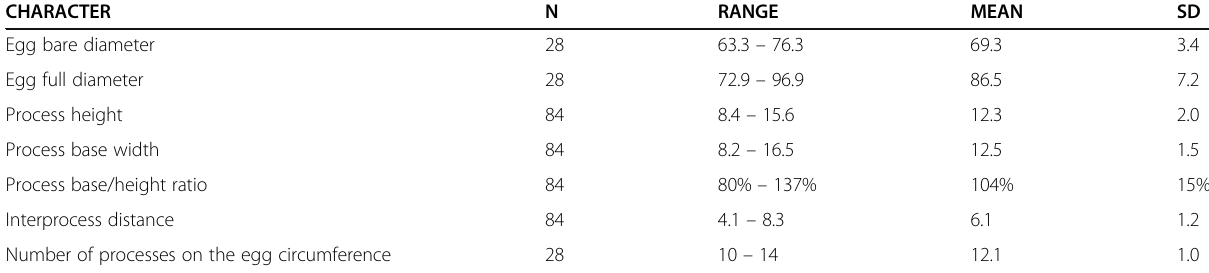
Table 13 Measurements [in μ m] of selected morphological structures of the eggs of Macrobiotus margoae sp. nov. from the USA (US.057) mounted in Hoyer ’ s medium (N – number of eggs/structures measured, RANGE refers to the smallest and largest structures among all measured specimens; SD – standard deviation) N